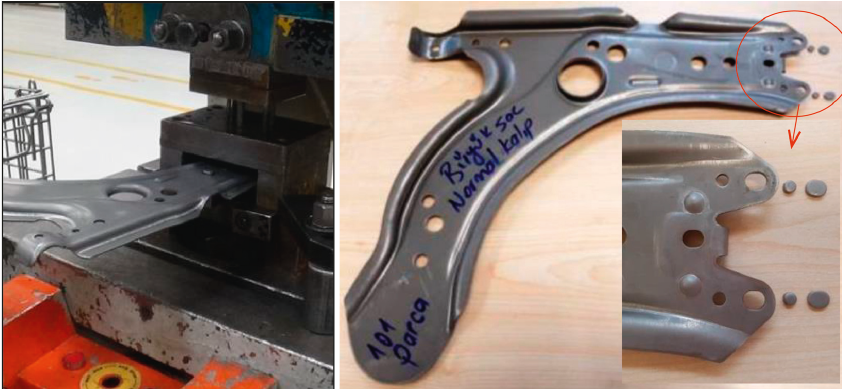
Figure 1: Die application and piercing pattern for slot and circular parts of the control arm. Table 1: Chemical composition of DIN EN 10111-98 sheet metal steel (by the sheet metal supplier). Elements (wt.%) C